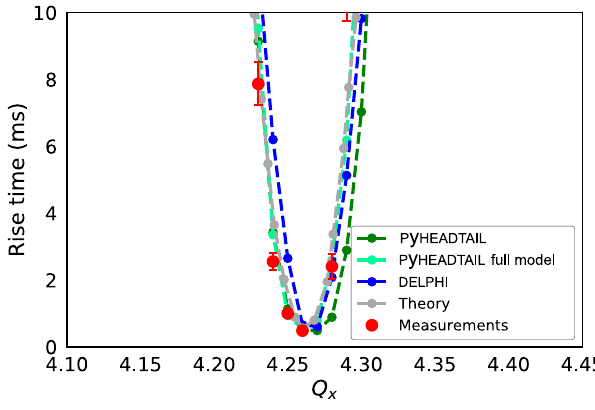
FIG. 9. Rise time versus Q x from measurements (red), P y HEADTAIL (green) and DELPHI (blue) simulations with the narrow-band resonator impedance model, and P y HEADTAIL sim- ulations (light green) and theory (grey) with the full PSB impedance